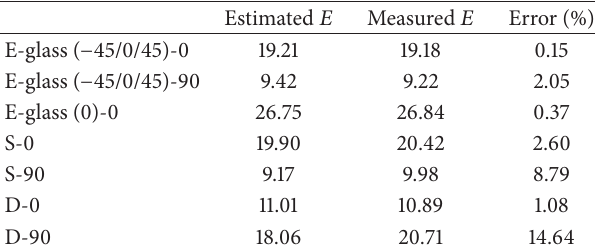
Table 5: The estimated and measured elastic modulus of the semicircular composites.